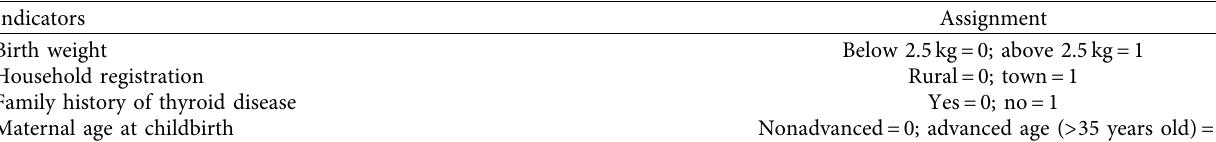
Table 3: Multifactor assignment table.